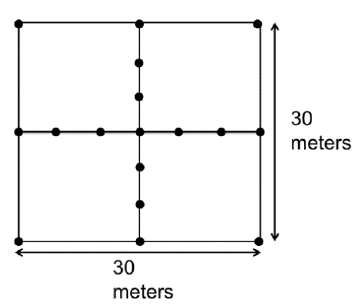
Figure 4. Sampling scheme. Measurements were acquired at 17 locations (black dots) within the 30m × 30m plot. 30 m × 30 m